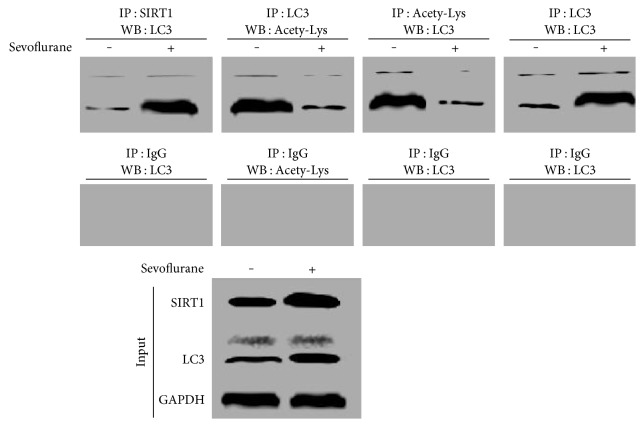
Sevoflurane increased deacetylation of endogenous LC3 by increasing the level of SIRT1. The binding of SIRT1 to LC3 and acetylated LC3 were detected by using coimmunoprecipitation assays and Western blot.